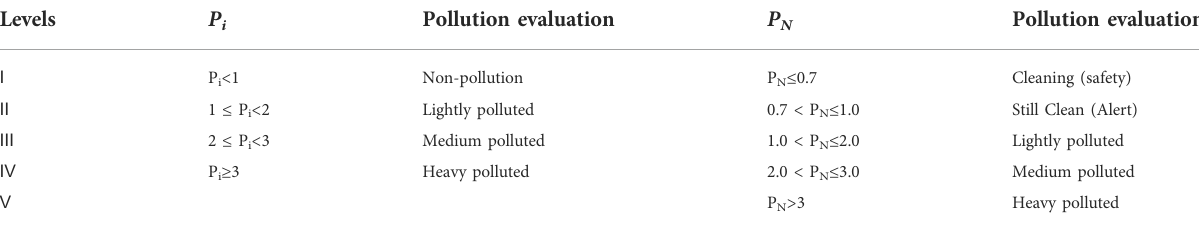
TABLE 3 Graded evaluation standards of heavy metal pollution index.